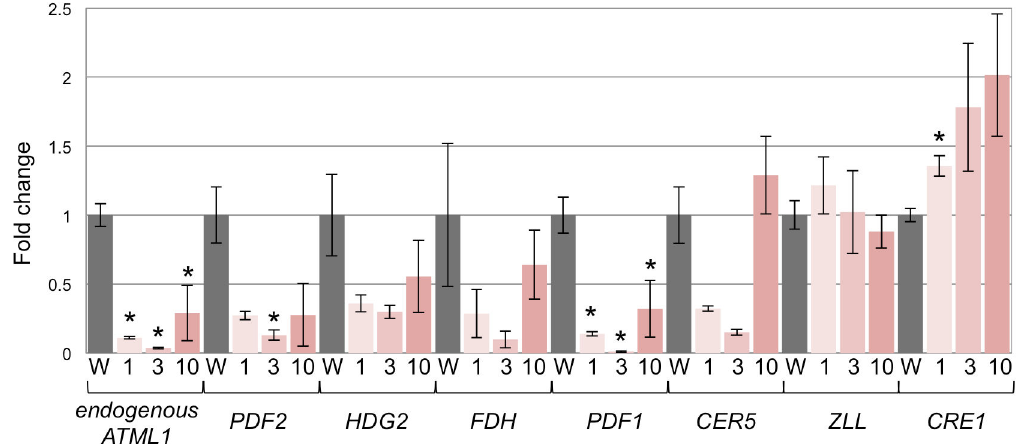
Figure 4. Quantitative RT-PCR analyses in ATML1-SRDX lines. Real-time RT-PCR analysis of the expression of endogenous ATML1, PDF2, HDG2, FDH, PDF1, CER5, ZLL, and CRE1 in seven-day-old seedlings of estradiol-inducible lines 1, 3, and 10 (1, 3, and 10, respectively) and the wild type (W) grown in the presence of 10 μM estradiol. Expression levels were normalized to PP2A expression [20], and expression in the wild type was set to 1. Values are the mean ± SEM from three biological replicates. Asterisks indicate a statistically significant difference relative to the wild type (unpaired two-tailed t-test; p < 0.05). CRE1 mRNA expression was significantly increased in ATML1-SRDX line 1. doi: